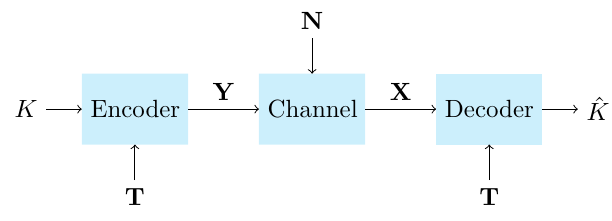
Figure 1: Representation of Side-Channel